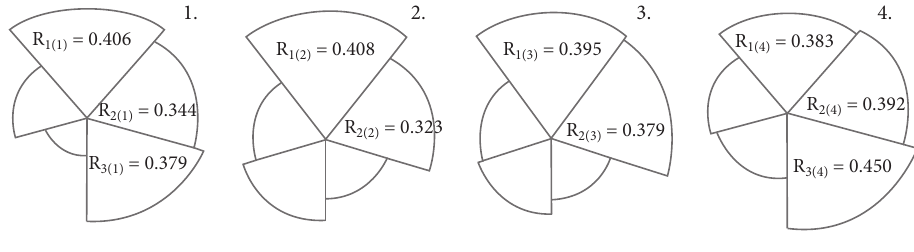
Fig. 2. A graphical view of